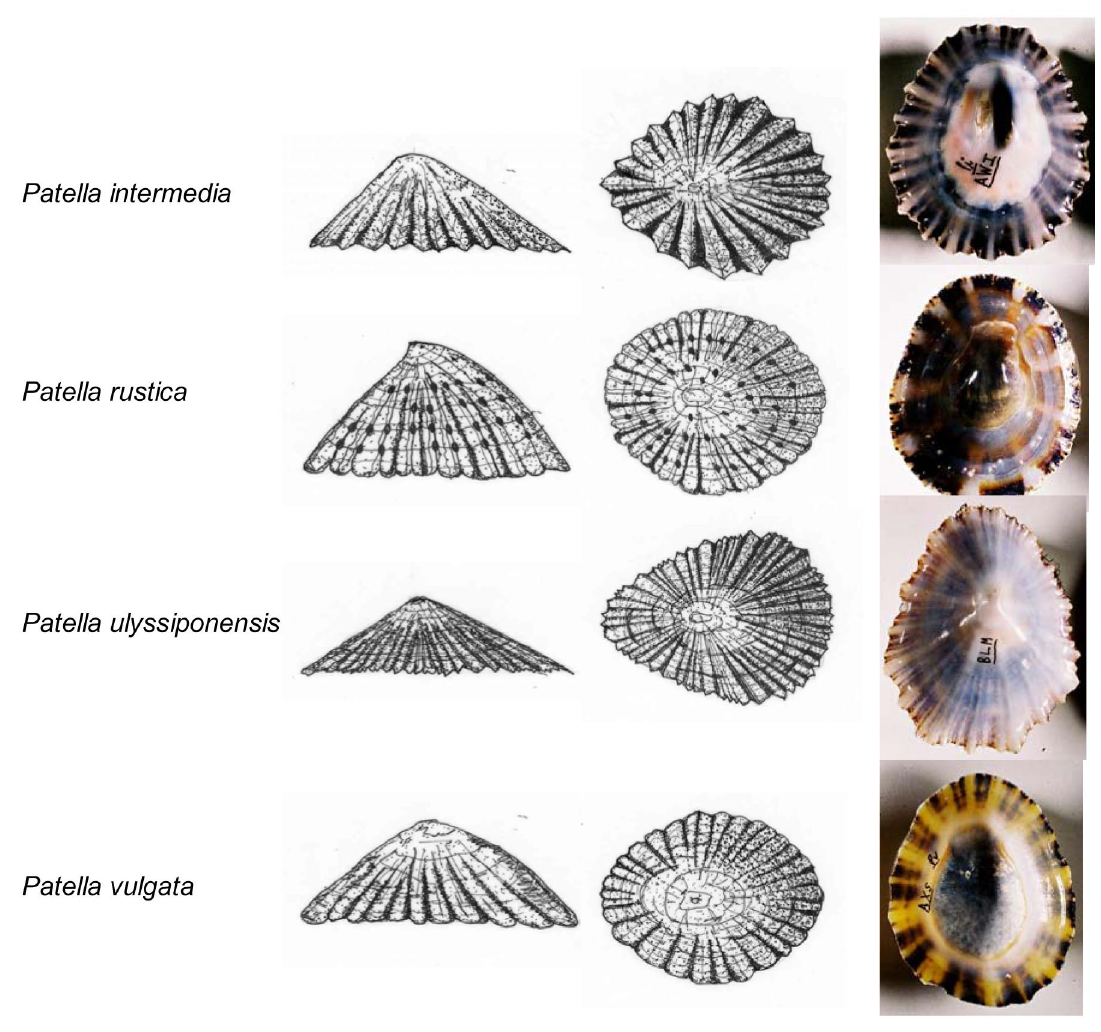
Fig. 1. Lateral (left), top (central) and interior (right) views of P. intermedia , P. rustica , P. ulyssiponensis and P. vulgata